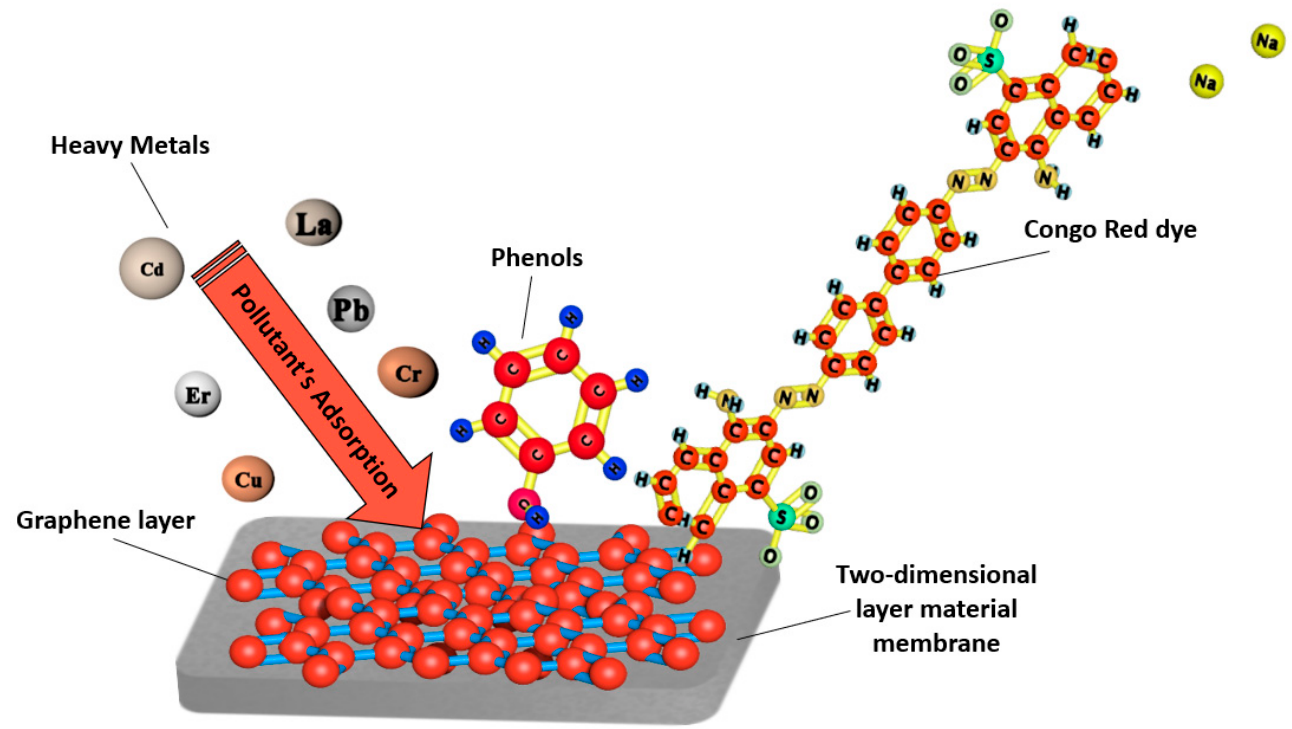
Figure 6. Schematic representation of heavy metals, dyes, and phenols adsorption by a graphene-based membrane for water treatment.